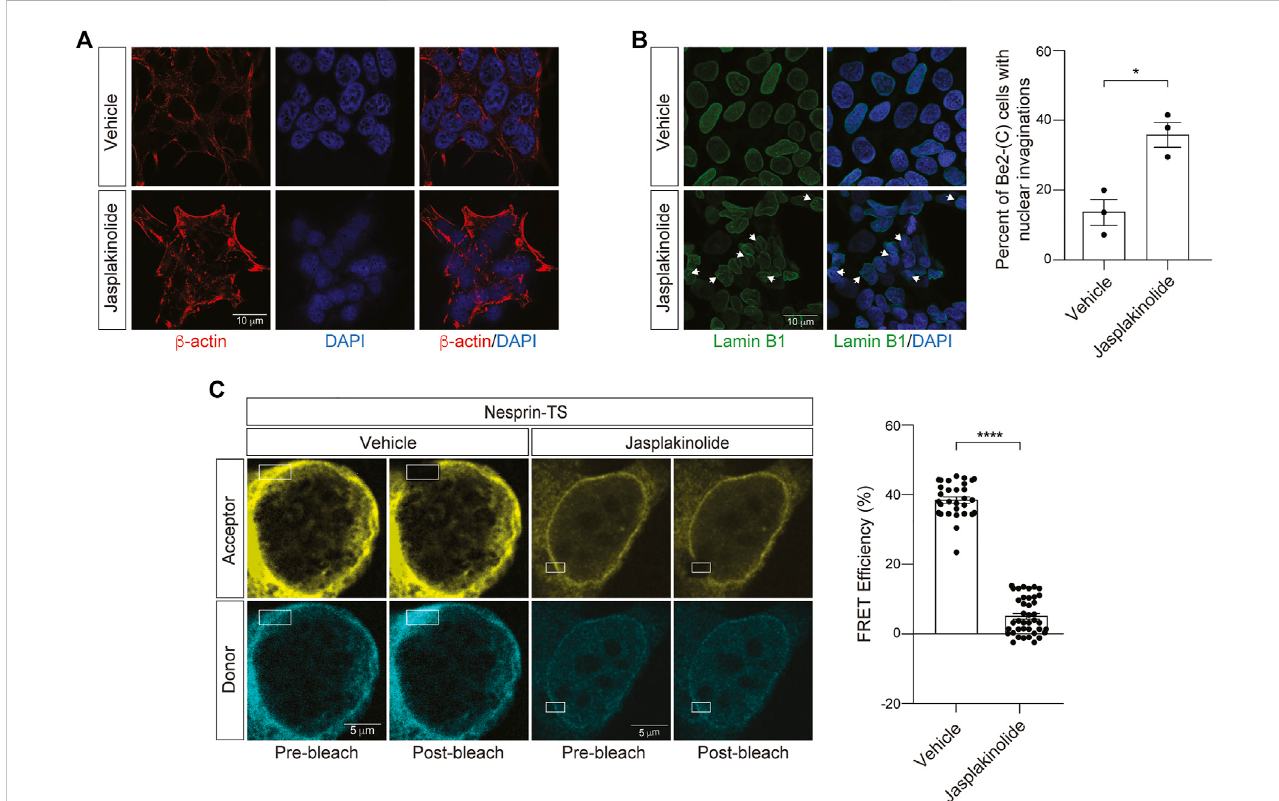
FIGURE 5 Jasplakinolide-inducedelevationofF-actinincreasesnucleartensioninneuroblastomacells. (A) Immuno fl uorescence-baseddetectionoftheactincytoskeleton followinga1-htreatmentofBE(2)-Ccellswith0.5 µMjasplakinolideorvehicle(DMSO). (B) Jasplakinolidetreatmentinducesasigni fi cantincreaseinnuclearenvelope invaginationsbasedonlaminB1immuno fl uorescence. n =3replicatespergroup, t -test,* p < 0.05. (C) Acceptorphotobleach-basedquanti fi cationofFRETinnesprin- TS expressingBE(2)-C cellsupontreatmentwith0.5 µMjasplakinolidecomparedto vehicle.EachdatapointrepresentsFRETanalyzedinasinglenucleus. Thirty nuclei were analyzed across three different wells (10 nuclei/well), t -test, * p < 0.05, **** p < 0.0001. Error bars indicate